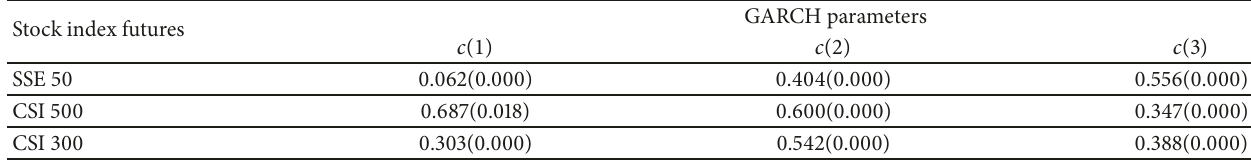
Table 8: The parameter estimation results of GARCH